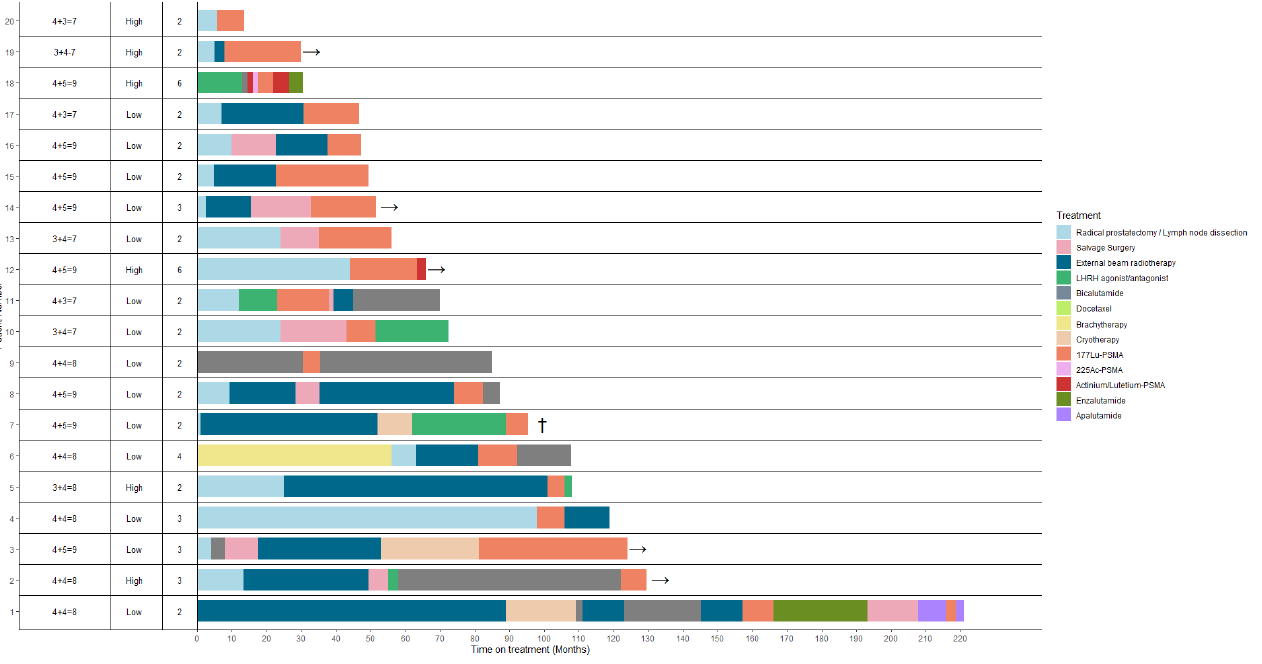
Figure 1. Swimmer plot illustrating the duration in months of each treatment per patient. Columns from left to right, initial Gleason Score; tumor volume at baseline (low volume was defined as having a maximum of 5 metastases); the amount of cycles each patient has received. Five patients have an ongoing response (indicated by the arrow), one patient has deceased (indicated by cross).